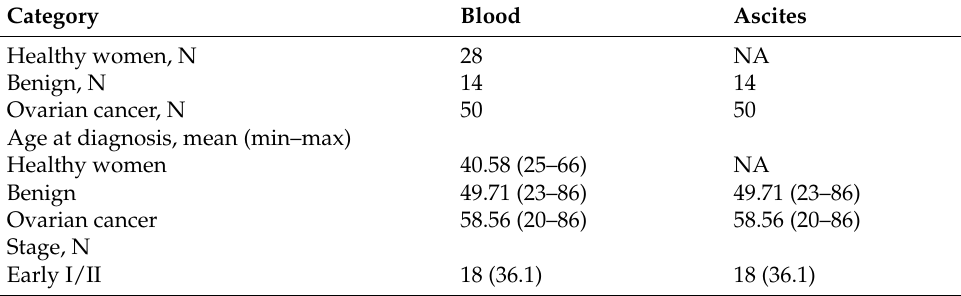
Table 1. Patient